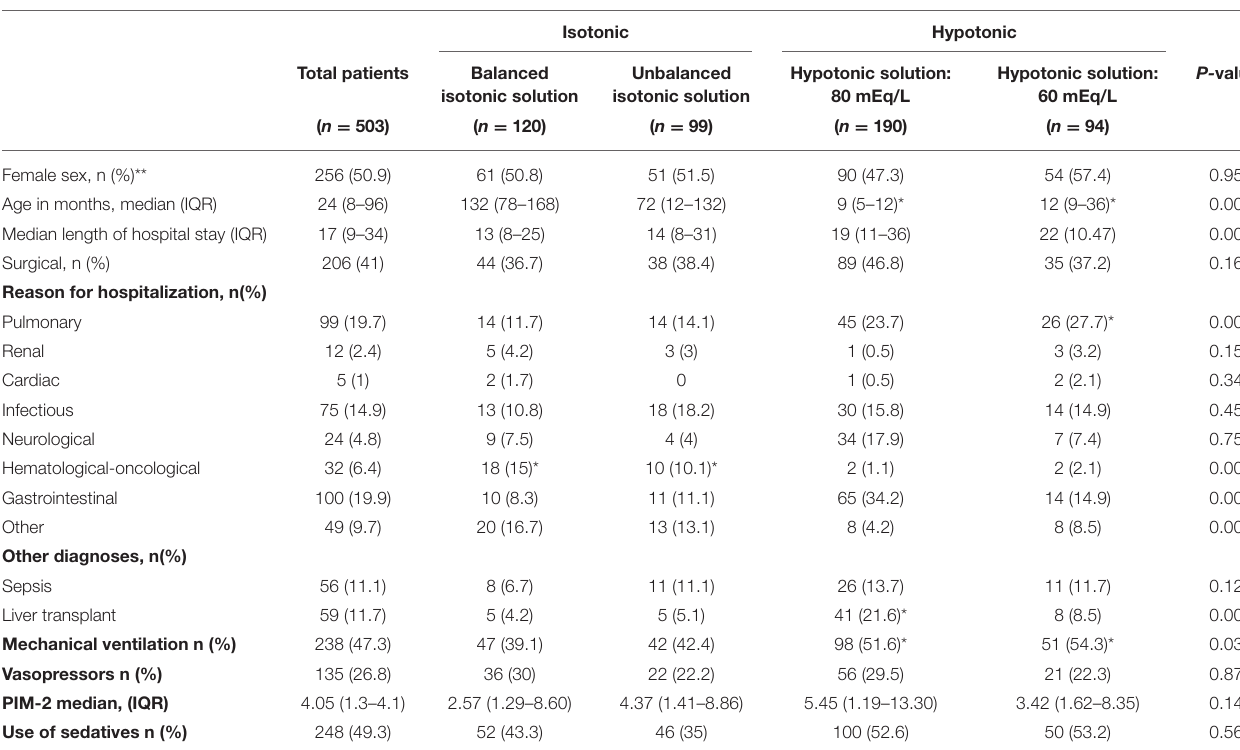
TABLE 1 | Characteristics of the study